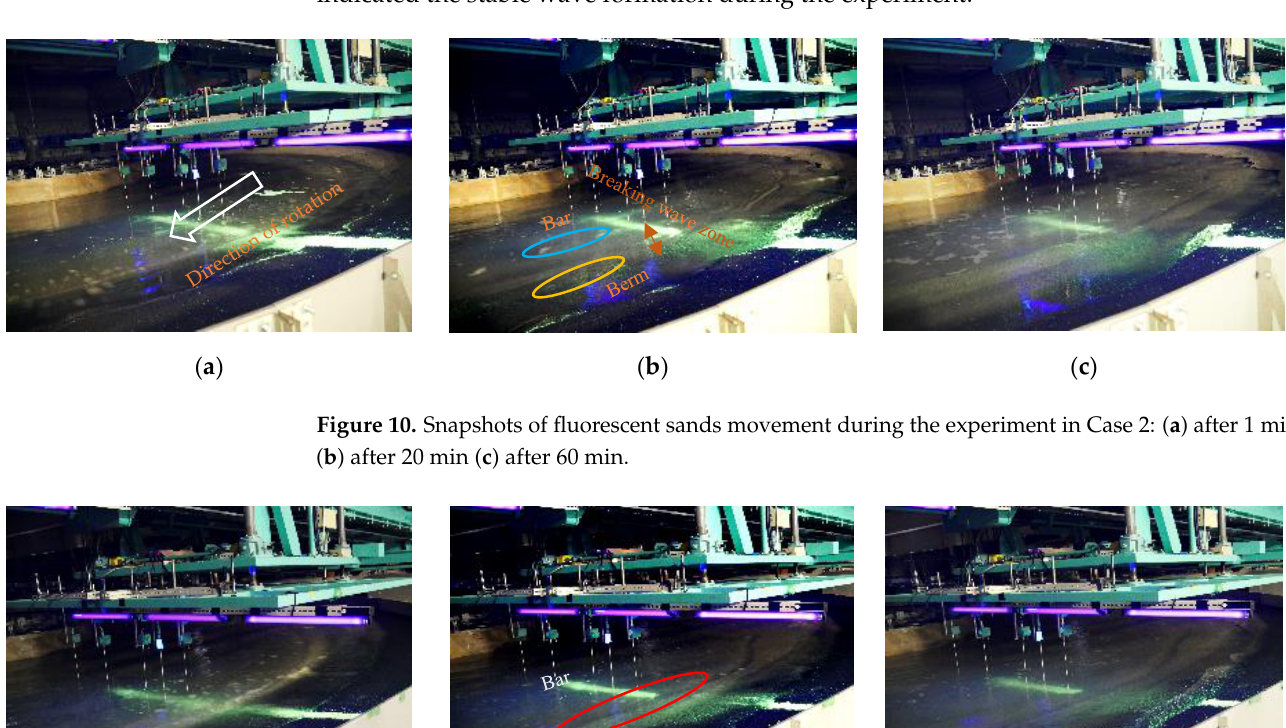
( c ) Figure 12. Snapshots of fluorescent sands movement during the experiment in Case 4: ( a ) after 1 min ( b ) after 5 min ( c ) after 60 min. The characteristics of the movement of sands were observed in two major stages; as in the first stage, the sands were actively moved towards the offshore direction from the shore area after the start of wave formation, and the movement was confirmed after 1 min in all cases, which was thought to be due to the upstream and downstream flow in the swash zone. The fluorescent sands were settled near the vicinity of the wave-breaking positions and the bar formation was confirmed in this stage. After the movement settled down, the displaced sands were moved in the direction of rotation of the wave-making device, which was considered the second stage. The settled-down situation of the sand displacement indicated the stable wave formation during the experiment. The gradual movement of the sands was consistent with the time-varying character- istics of the flow velocity, and the velocity affected the dynamics of sediment transport in the two stages. However, the time duration of the fluorescent sand movement in the alongshore direction was different in different wave conditions. Regarding the rotation speed of the wave-making device and wave heights, the shifted situation occurred earlier in case 4 (after 5 min) compared with the other cases (after 20 min in case 2 and 10 min in case 3). It was also observed that the sands were moved along the onshore and offshore direction following the mechanism of uprush and backwash in the swash zone; the same procedure of sands displacement profiles in the swash zone was found by Puleo et al. [8] in their field study. Therefore, it can be deduced that the movement of sands in the first stage was greatly related to the cross-shore sediment transport and bar formation, which was relatively dependent on the generated wave heights, wave breaking positions, and wave periods, respectively. When the movement of sands along the cross-sectional topog- raphy was settled down, the accumulated sands within the bars and berms were moved to the alongshore direction that could be occurred due to the influence of obliquely